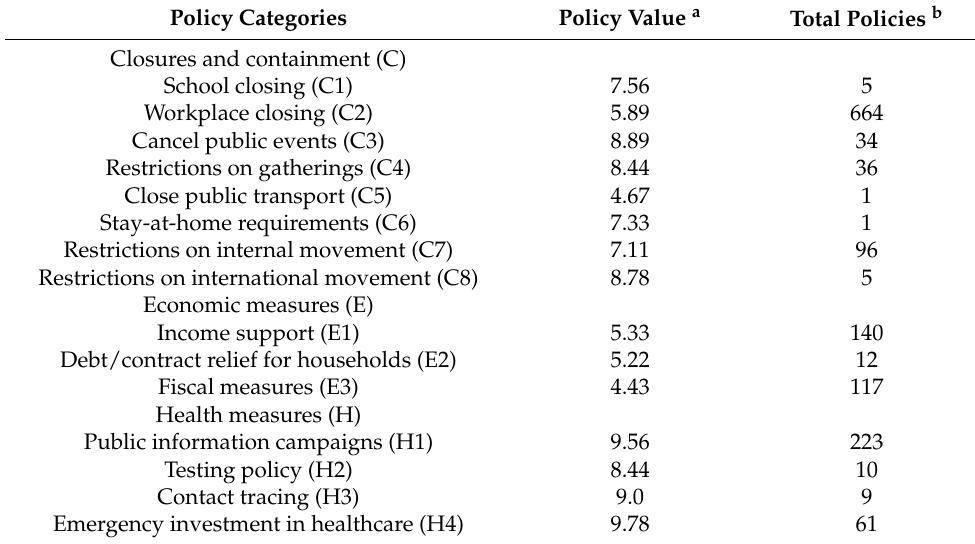
Table 1. Categories, values and total number of policies to contain the health emergency due to COVID-19 in